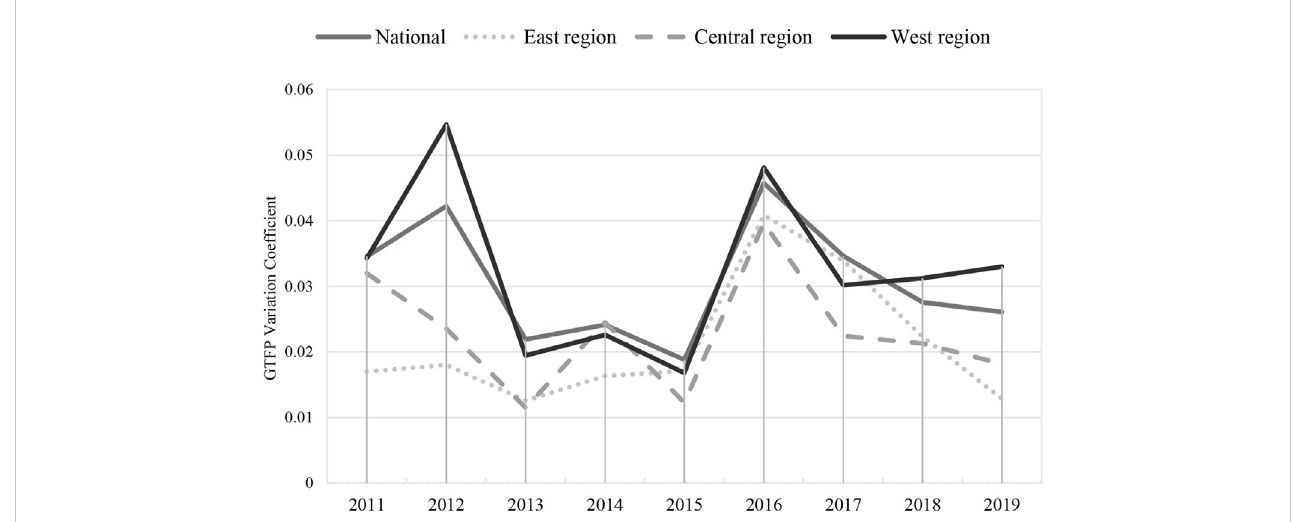
FIGURE 3 GTFP Variation Coef fi cient in China and East, Central and West Urban Agglomerations annual trend.